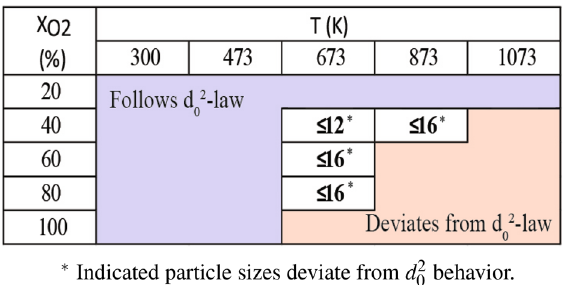
Table 4. Conversion behavior for combination of diameter, temperature and O 2